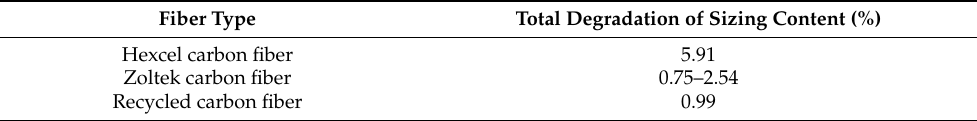
Figure 6. Thermogravimetric analysis curves of Zoltek, Hexcel, and recycled carbon fibers heated in air from room temperature to 900 °C, showing the oxidation degradation of the fibers. Table 3. Thermogravimetric isothermal properties of carbon fibers in a nitrogen atmosphere.